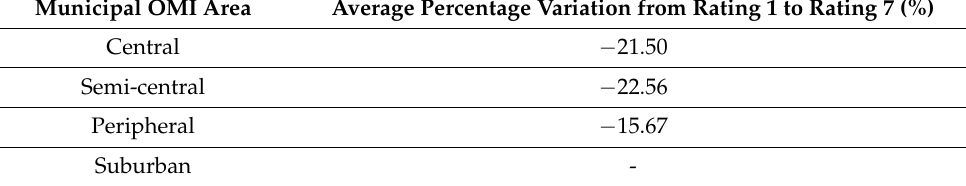
Table 7. Percentage variation in the market prices from rating 1 to rating 7 for the four municipal OMI areas of the city of Bari.